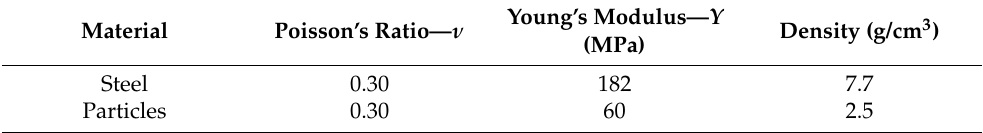
Table 3. Summary of material parameters.